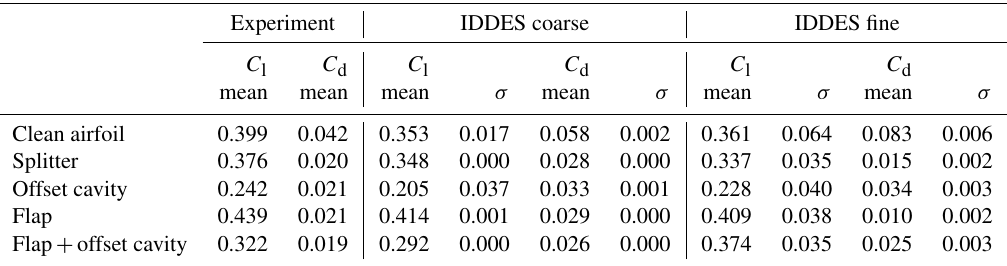
Table A1. Mean and standard deviation ( σ ) values for lift and drag coefficients. Comparison between experiments and IDDES results for the coarse and fine mesh.